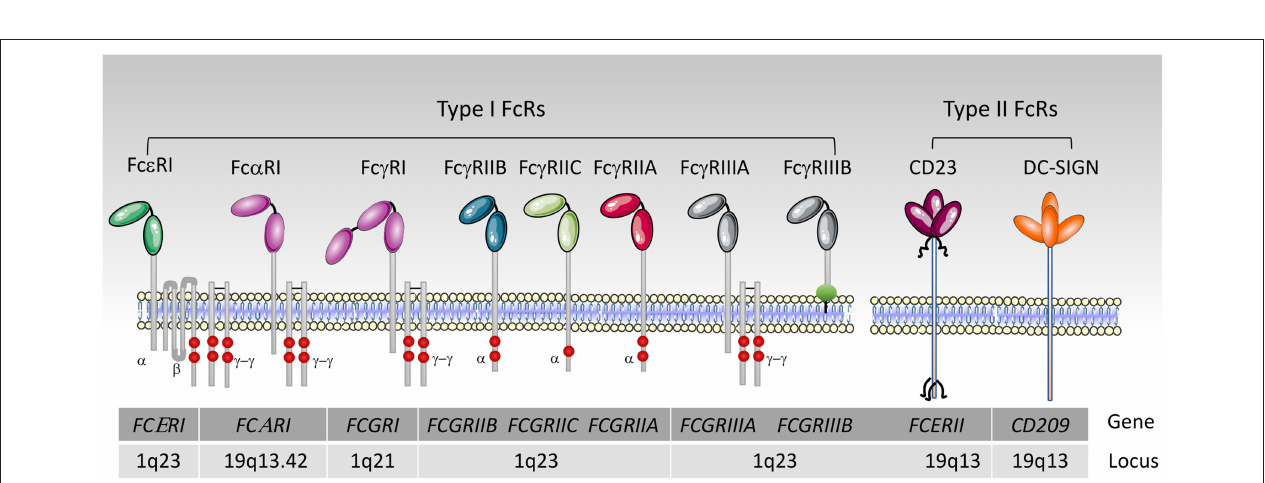
FIGURE 2 | Organization and conformational rearrangements of the IgE Fc. (left) , IgE and the binding sites to Fc ε RI (green) and to CD23 (pink) [adapted from Pennington et al. (24)] (Middle and Right) . Representation of the open and closed conformations, respectively, of the IgE Fc C ε 3–4 domains, and the mutual allosteric inhibition by Fc ε RI α (green) and CD23 (pink).